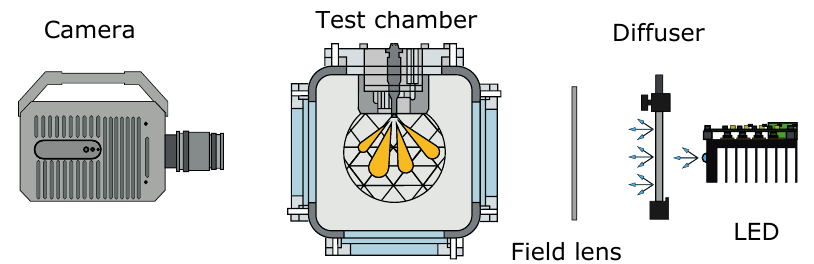
Figure 3. DBI optical setup for liquid phase visualization.